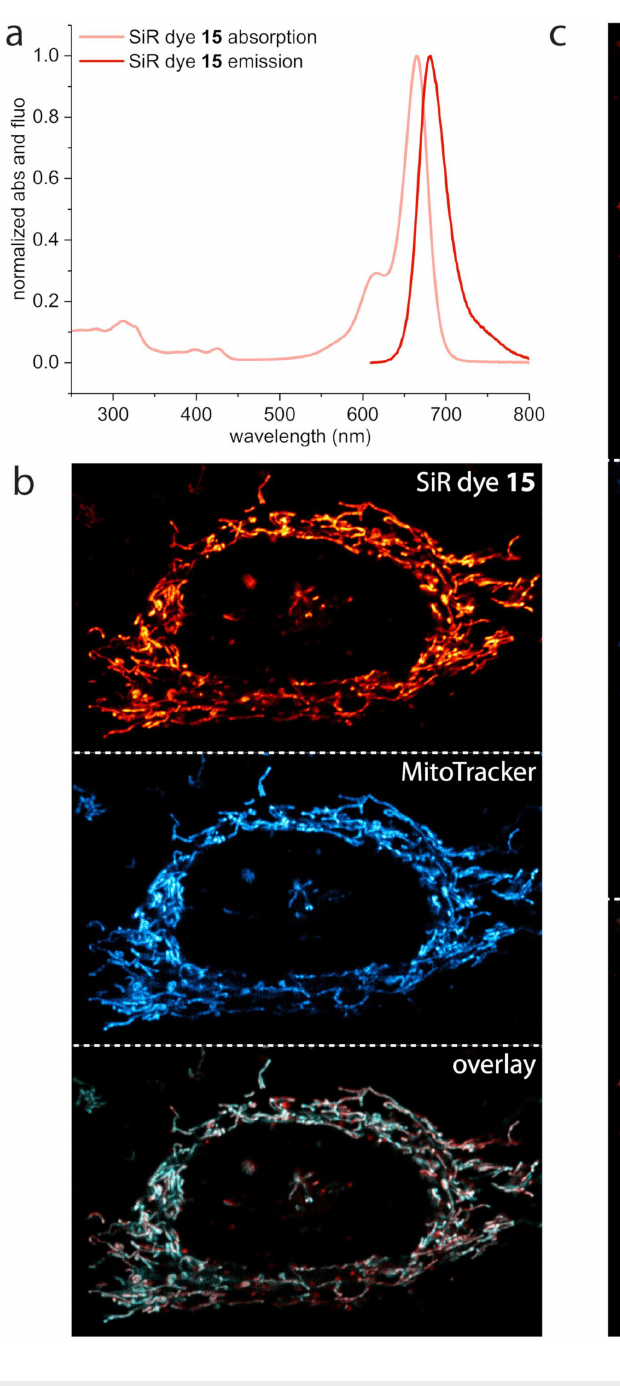
market. Therefore, we are interested also in purposes other than PET imaging or macroscopic fluorescence imaging. Histopatho- logical examinations of biopsy material on subcellular level